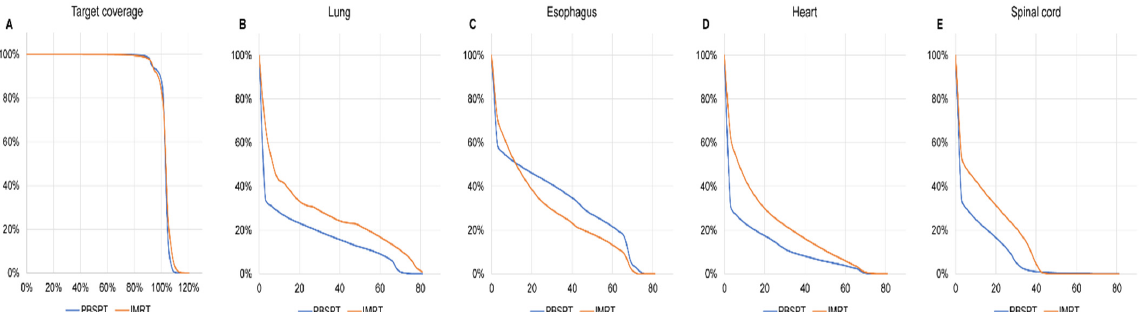
Figure 4. Dose–volume histogram for an average of matched intensity-modulated radiation therapy (IMRT) and pencil beam scanning proton therapy (PBSPT) plans: planning target volume ( A ); both lungs ( B ); esophagus ( C ); heart ( D ); spinal cord ( E ). Abbreviations: IMRT, intensity-modulated radiation therapy; PBSPT, pencil beam scanning proton therapy.